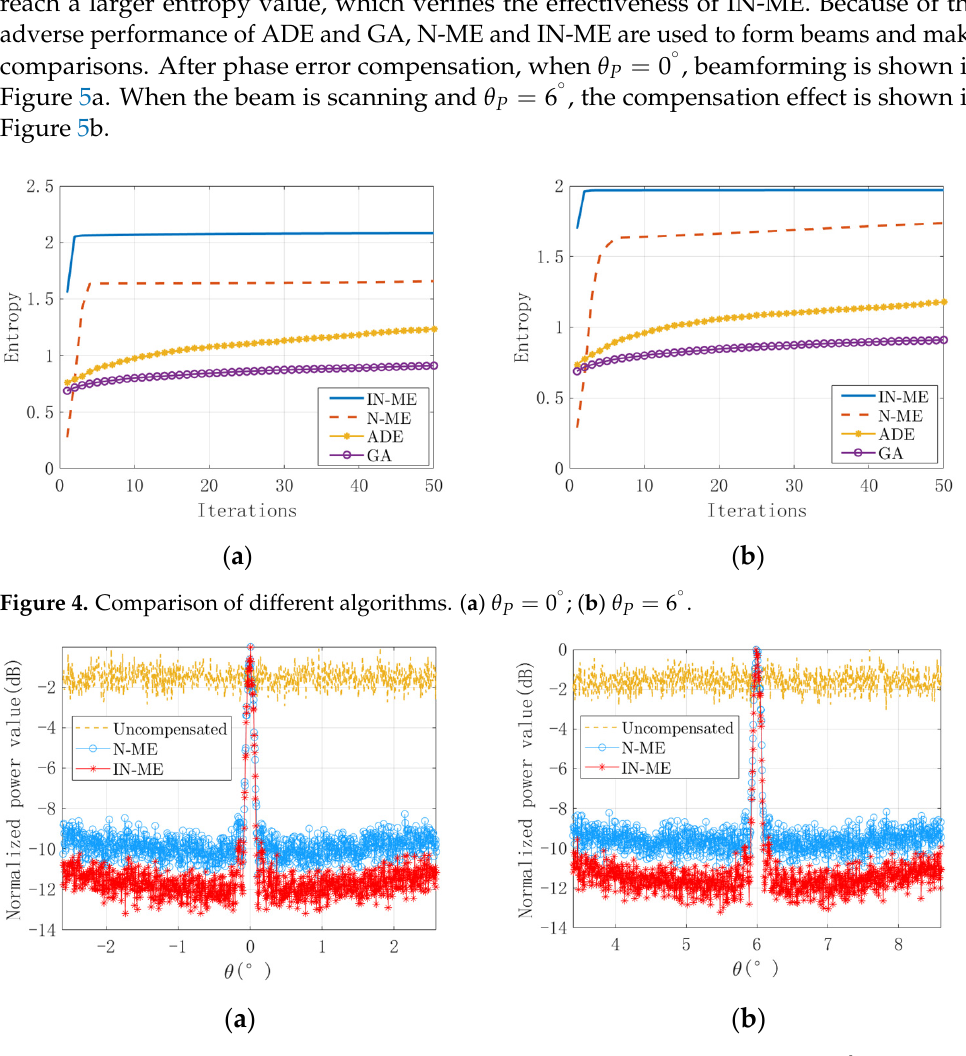
Figure 5. Comparison of the beam forming effect after phase compensation. ( a ) θ P = 0 ◦ ; ( b ) θ P = 6 ◦ .